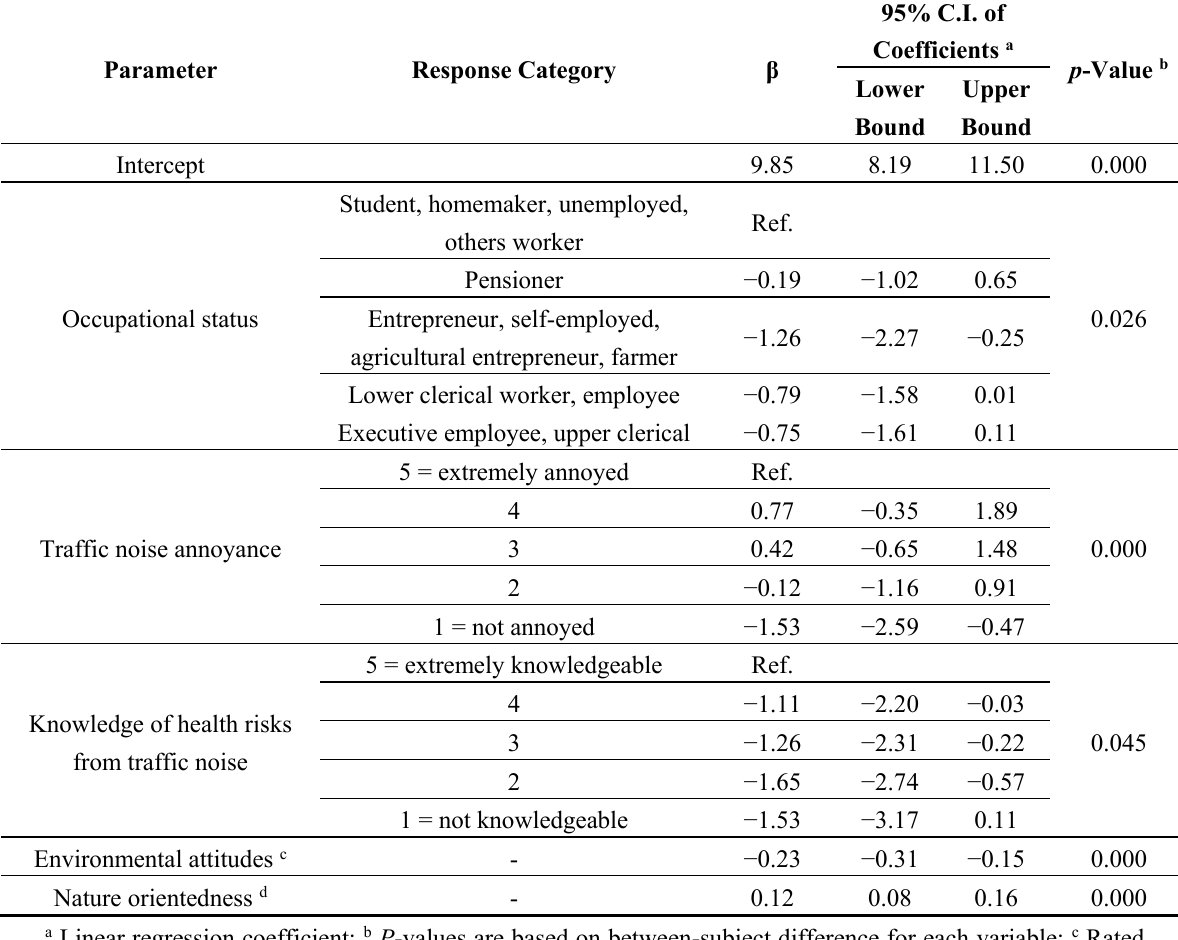
Table 5. Determinants of noise